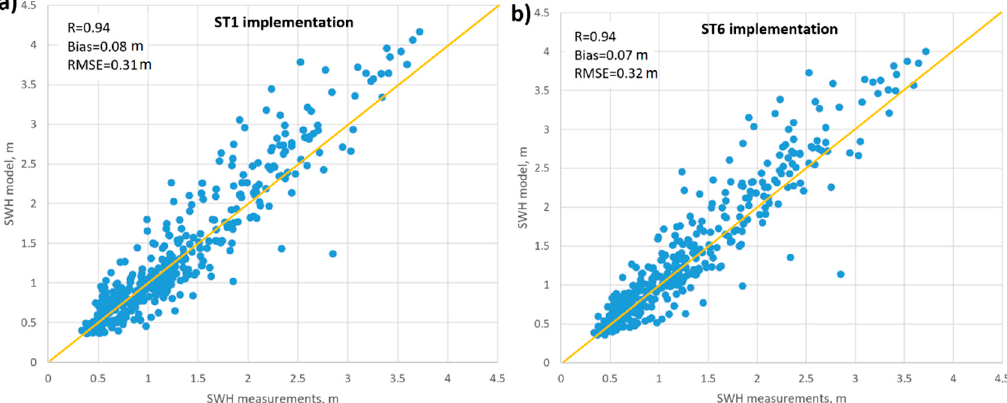
Figure 3. Scatter diagram of measured on the mooring station and simulated SWH for two model implementations: ( a ) ST1, ( b ) ST6.